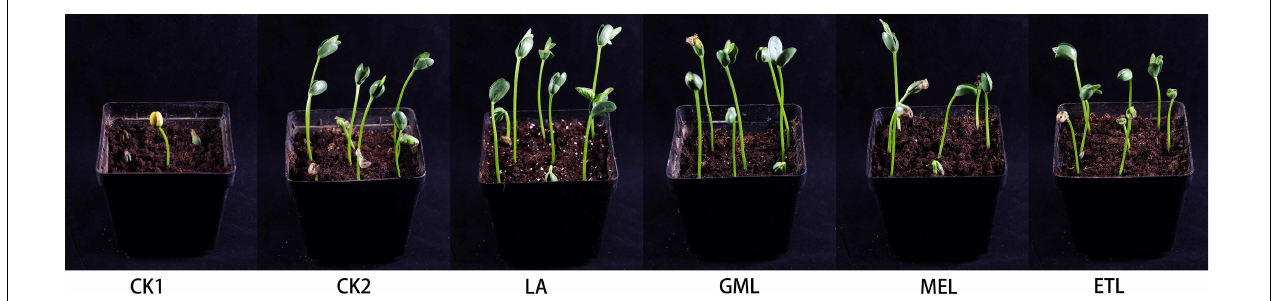
FIGURE 6 | Potted experiment of P. sojae control by LA and its derivatives. The soil was treated with LA, GML, MEL, or ETL. In CK1, no agent added to the soil. In CK2, no P. sojae mycelium was added to the soil. Plant height was measured 5 days after planting. The experiment was repeated three times with similar results. Means with different letters are significantly different (SPSS, p <